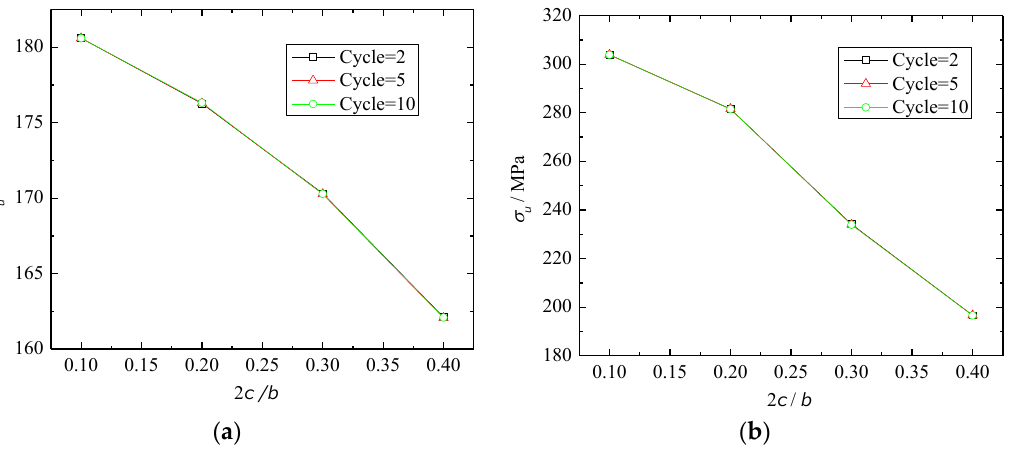
Figure 9. Residual strength at different number of cycles: ( a ) compressive residual strength; ( b ) tensile residual